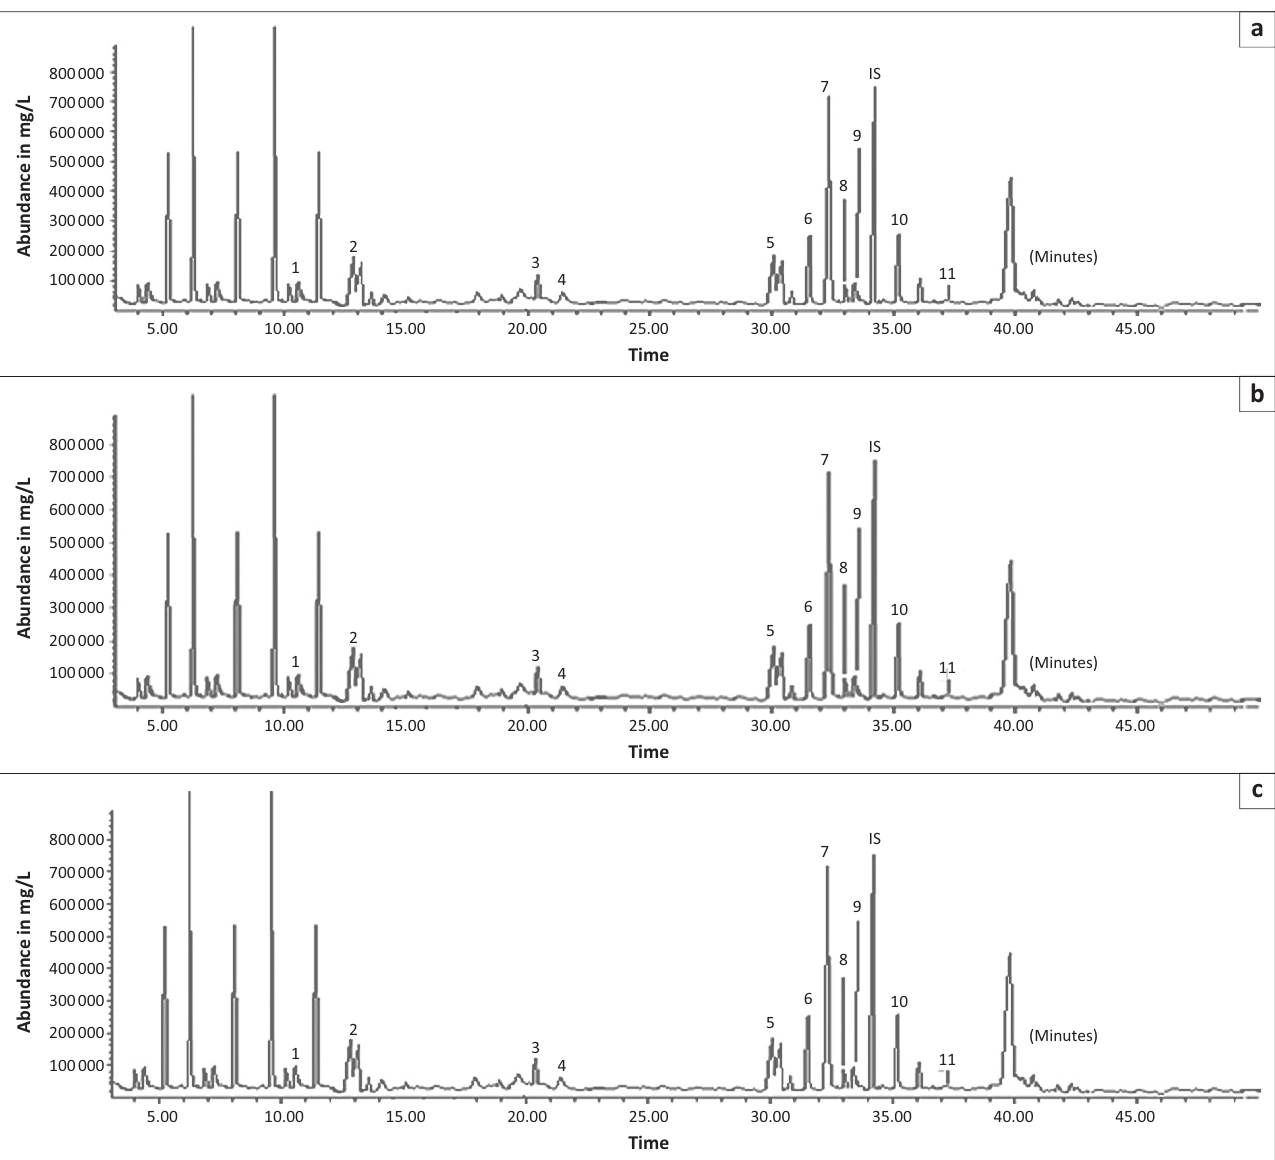
IS, internal standard. FIGURE 1: Gas chromatography-mass spectrometry chromatogram for phenolic extracts of day twenty buffalo, cattle and eland urine samples. (a) Buffalo; (b) Cattle; (c) Eland. Peaks identities: (1) 4-cresol, (2) phenol, (3) ortho-cresol, (4) 3-cresol, (5) 4-ethylphenol, (6) 3-ethylphenol, (7) 3-propylphenol, (8) 4-propylphenol and (9)